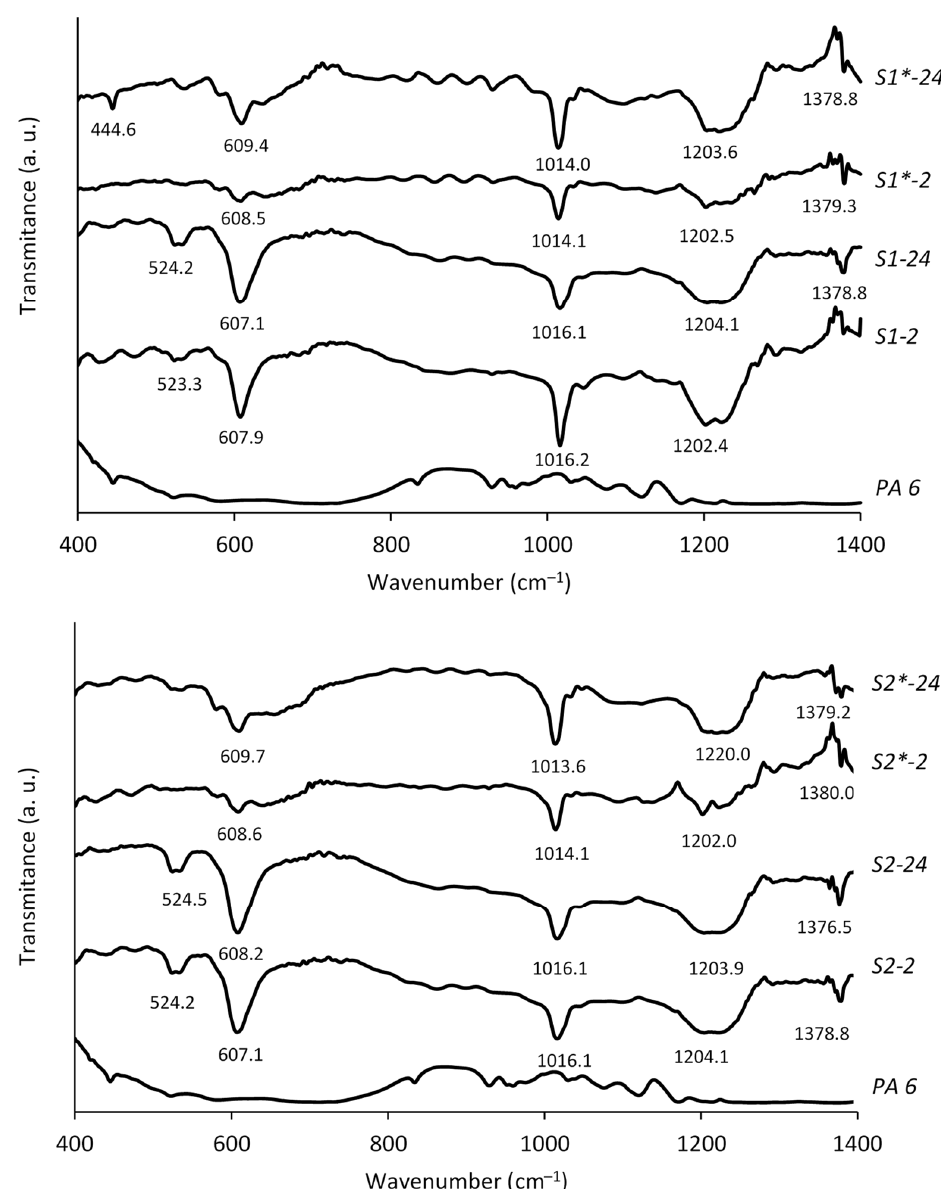
Figure 5. FTIR absorption spectra of PA 6 chalcogenized samples in the solutions of H 2 TeS 4 O 6 and samples with the layers of cadmium chalcogenides on the PA surface.